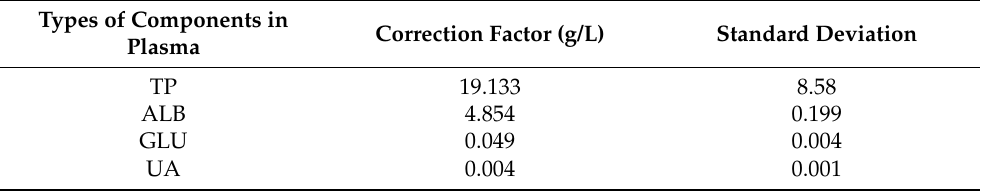
Table 1. Concentration correction value for the plasma component measurement.